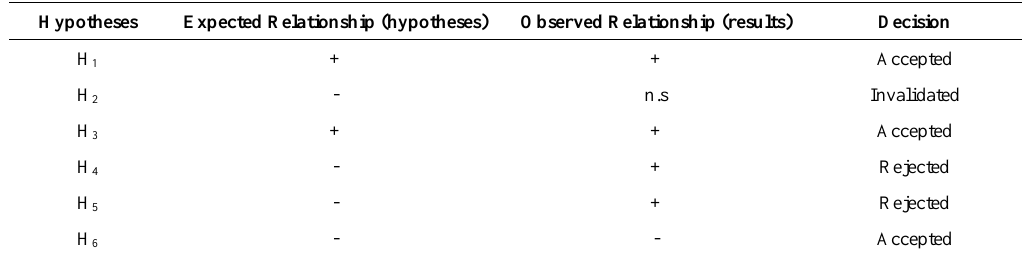
Table 8. Confrontation between expected relationship and observed